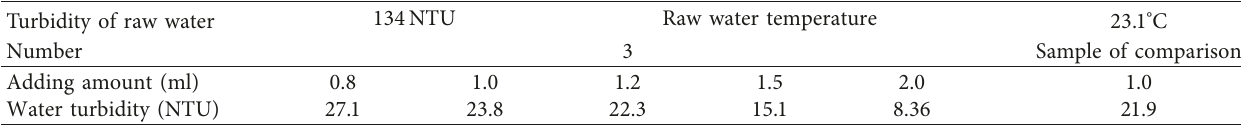
Table 5: Formula no. 3 treatment of tap water source water-related